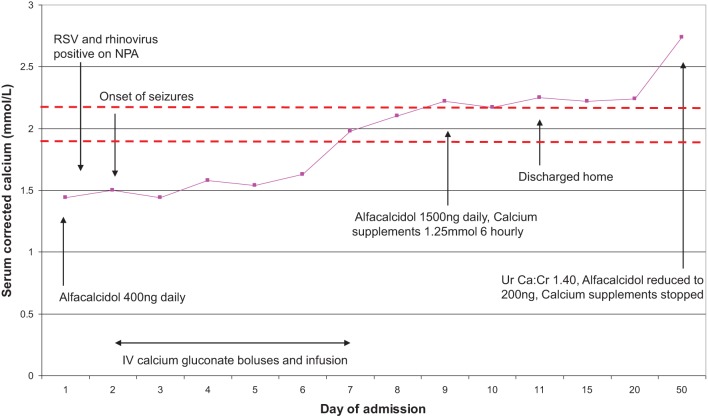
Presentation and progress of case 2 during bronchiolitis illness, demonstrating changes in serum corrected calcium during admission and management needed. NPA – nasopharyngeal aspirate; RSV – respiratory syncitial virus; Ur Ca:Cr – urinary calcium:creatinine ratio. Dotted lines indicate the range of optimal serum corrected calcium concentration for children with severe hypoparathyroidism (1.9–2.2 mmol/L).